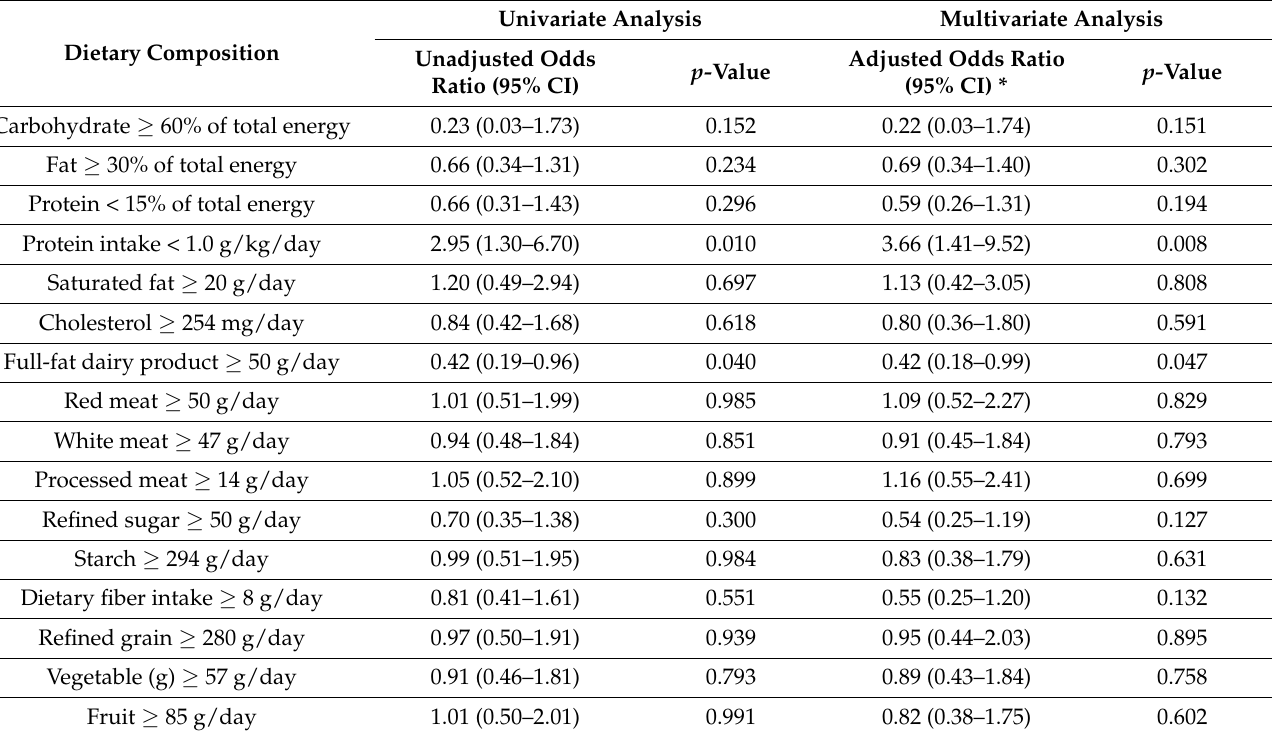
Table 3. Unadjusted and adjusted odds ratios of dietary composition associated with nonalcoholic fatty liver disease.